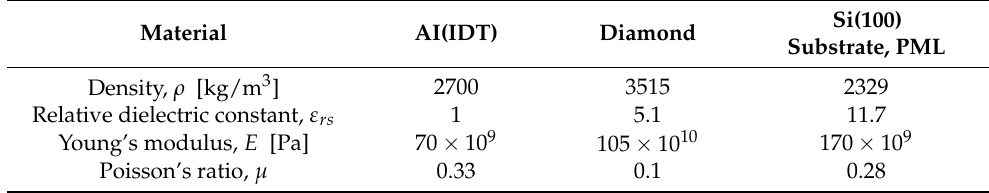
Table 2. Parameters of piezoelectric materials used in the simulation model.